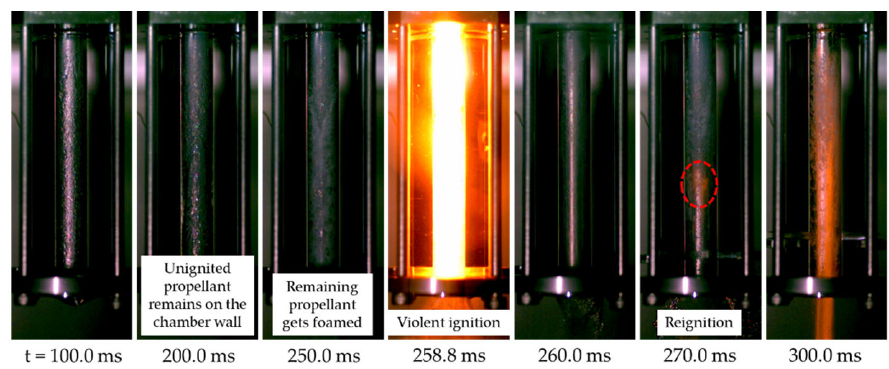
Figure 15. High ‐ speed camera images of hard start case. Figure 15. High-speed camera images of hard start